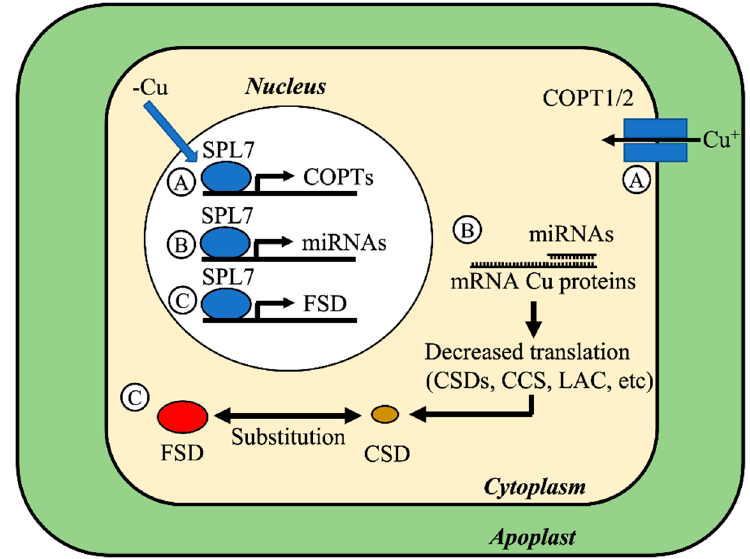
Figure 1. The Cu economy response in Arabidopsis thaliana is orchestrated by AtSPL7. A Cu deficiency signal activates AtSPL7, which in turn binds to CuRE (Cu Responsive Elements) in target gene promoters. The AtSPL7 targets are: ( A ) high affinity Cu transporters from the COPT family, which are targeted to the plasma membrane and promote Cu uptake from the extracellular space; ( B ) miRNAs from the miRNA397, miRNA398, miRNA408, and miRNA827 families, which target mRNAs from proteins that use Cu as cofactor, such as Cu/ZnSOD (CSDs), Laccases (LAC), and Cu chaperones (such as CCS), decreasing the Cu usage and saving Cu for plastocyanin; ( C ) proteins that perform similar functions as Cu-using counterparts, such as FeSOD (FSD), which accumulate and substitute cuproproteins such as CSDs.